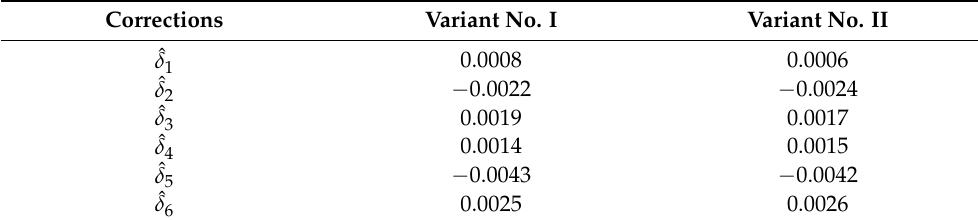
Table 6. The obtained corrections ˆ δ [mm].